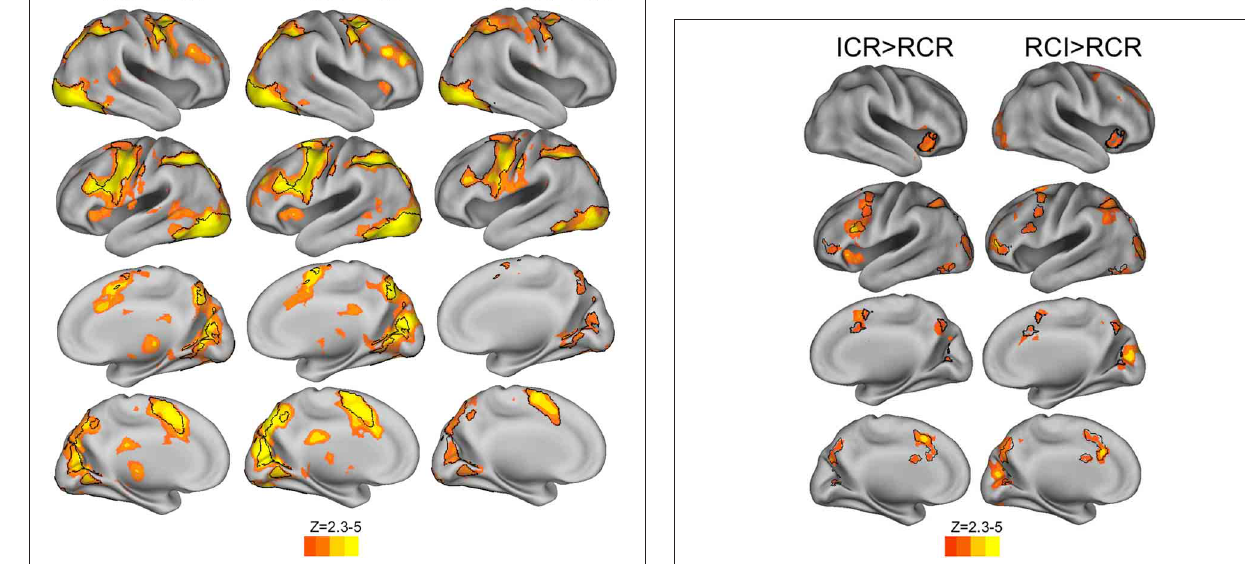
FIGURE 4 | BOLD responses to context vs. fixation (red-yellow) and common areas of recruitment (black outlines). Relative to fixation, each of the three conditions elicited a reliable BOLD response across frontal, parietal, and occipital cortex. Most significant frontal activation, whether medial and lateral, was observed in the left hemisphere (voxelwise z > 2 . 3, corrected to p < 0 . 05 via GRF).